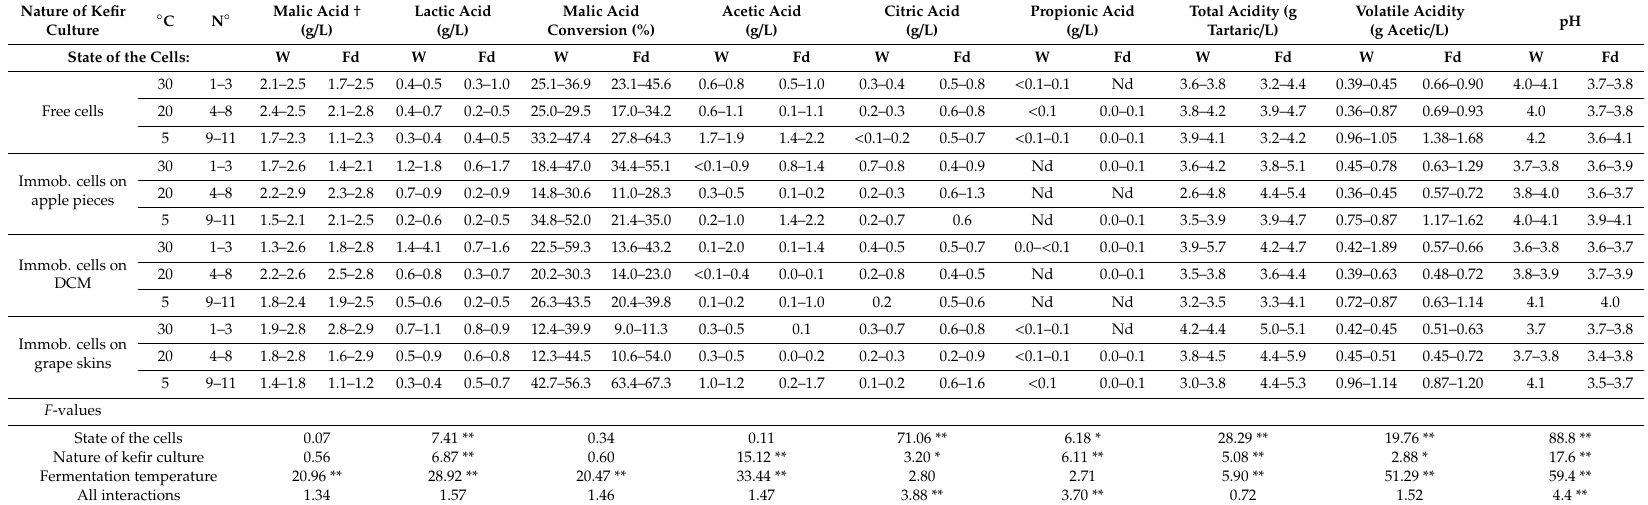
Table 3. Organic acids profile and enological parameters of low alcohol wines produced by repeated batch fermentations at 5–30 ◦ C using wet or freeze-dried kefir